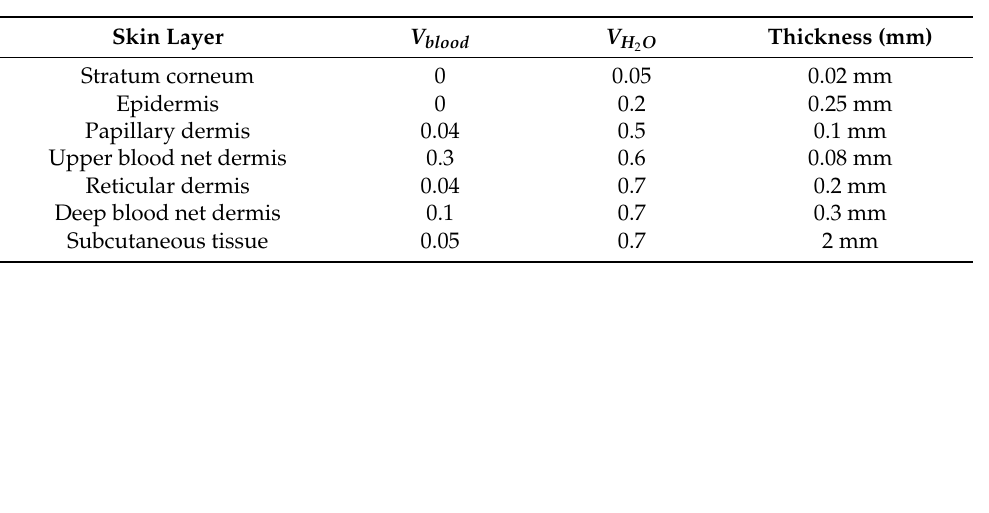
Figure 2. The refractive index values used in this model are 1 for air and 1.4 for tissue [31]. Table 1. Values utilized in Equation (1) for the estimation of the absorption coefficients. The values were taken from